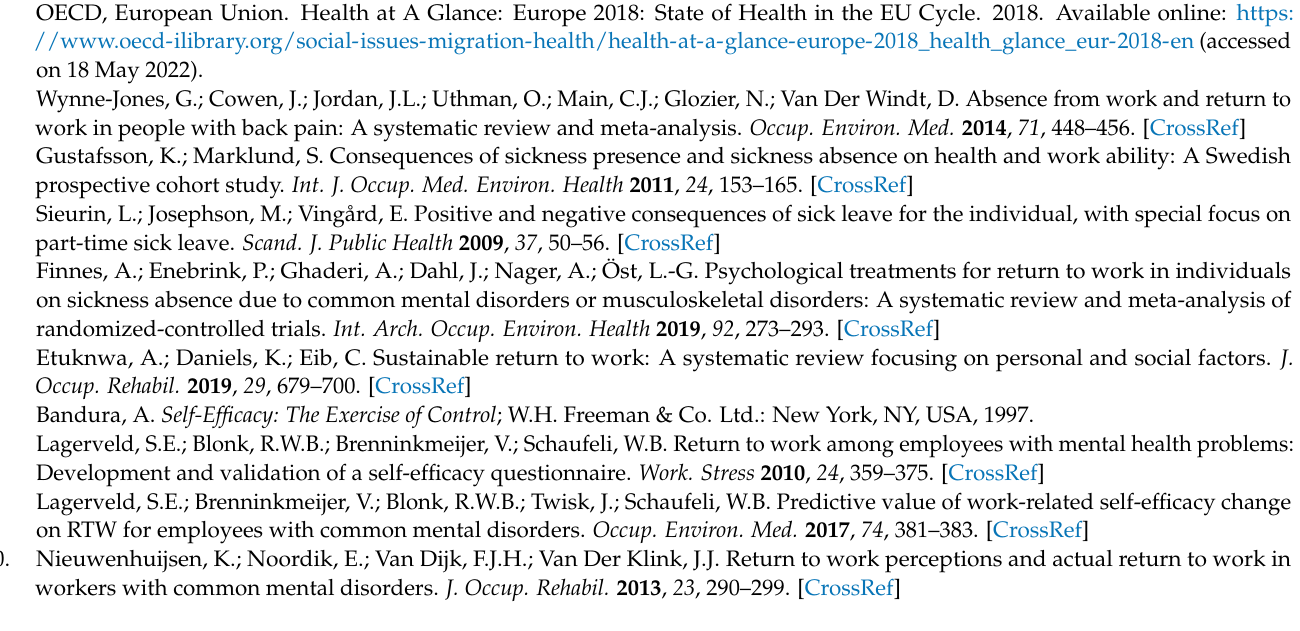
instruments of the present study. Table S2: Means and standard deviations of the RTW-SE items. Table S3: Skewness and kurtosis indices for scale scores of original baseline data. Table S4: Factor loadings of the RTW-SE items for the one-factor solution and the two-factor solution (standardized regression coefficients). Table S5: Correlations coefficients between physical performance (PACT)/pain-related Table S6: Internal consistency values of the RTW-SE